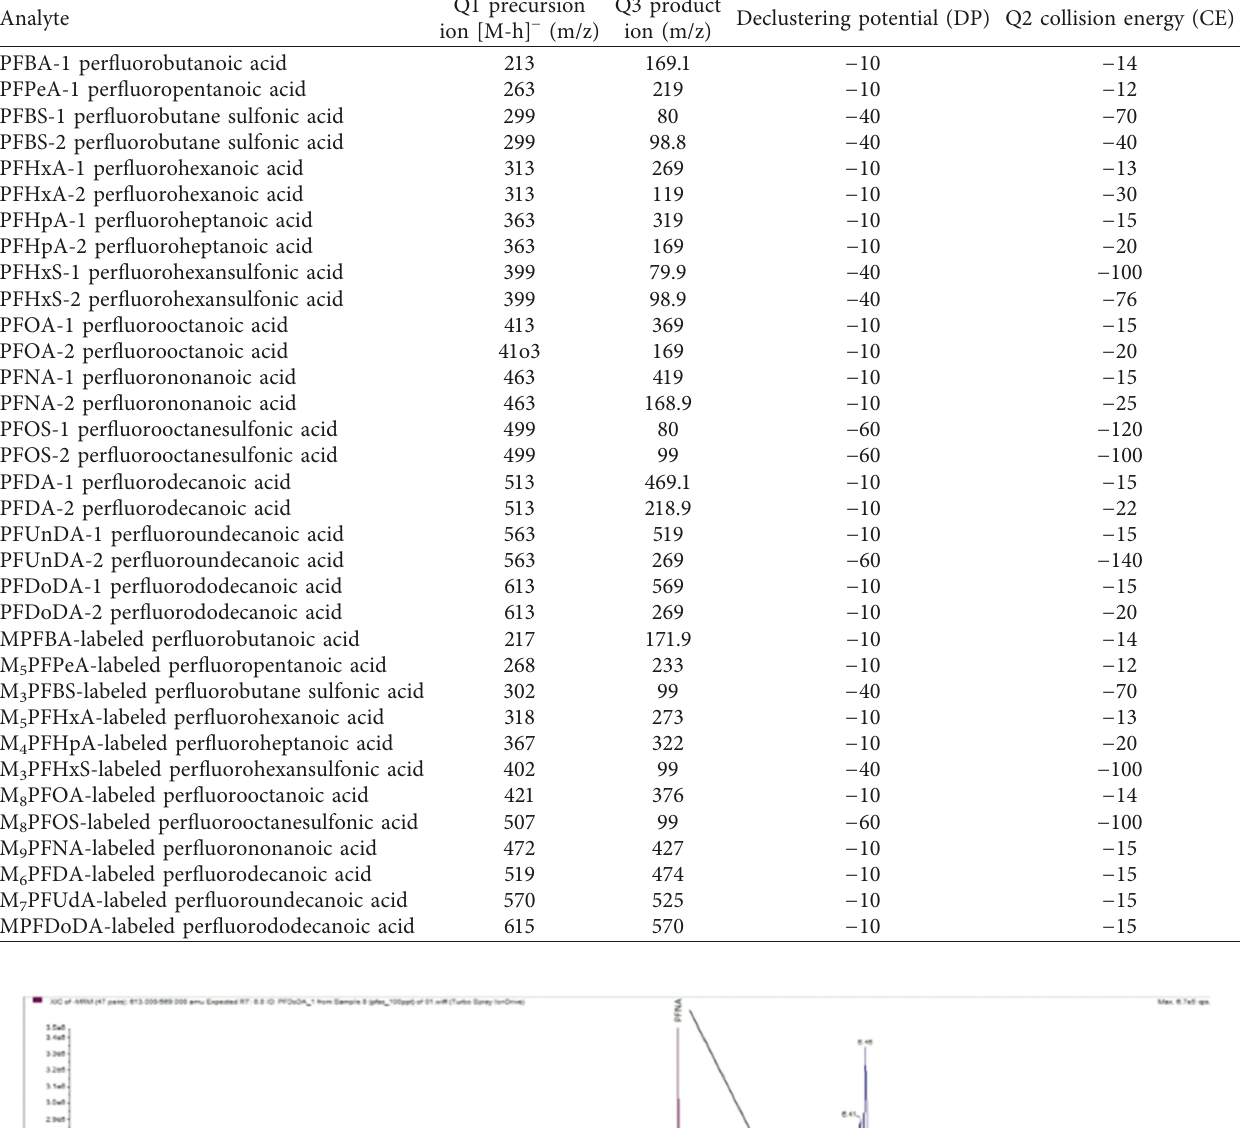
Table 4: m/z, declustering potential and collision energy used.